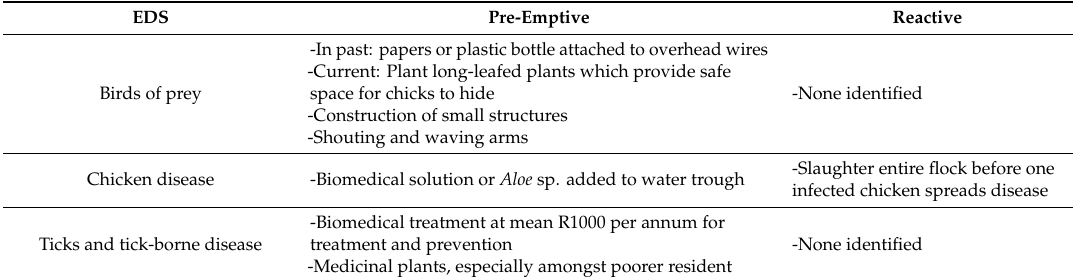
Table 7. Pre-emptive and reactive strategies to reduce crop loss across all three villages.